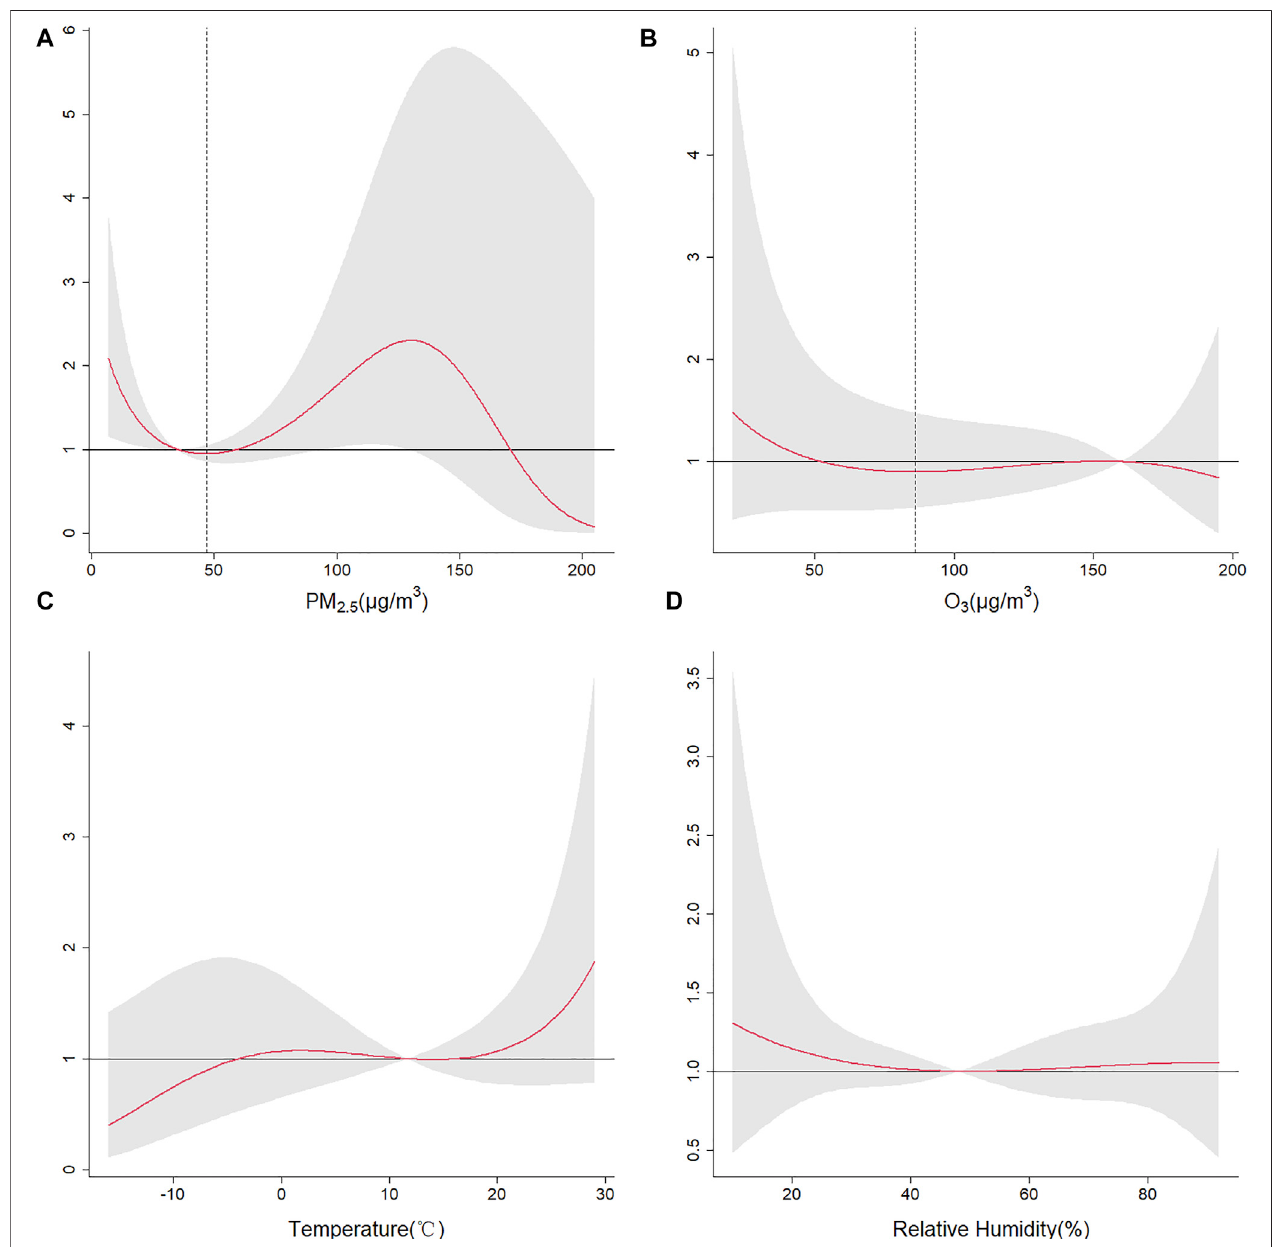
FIGURE 1 | Plot of cumulative RR of mumps by environmental factors in Ningxia, 2015 – 2019. (A) For PM 2.5 ; (B) for O 3 ; (C) for temperature; and (D) for relative humidity.